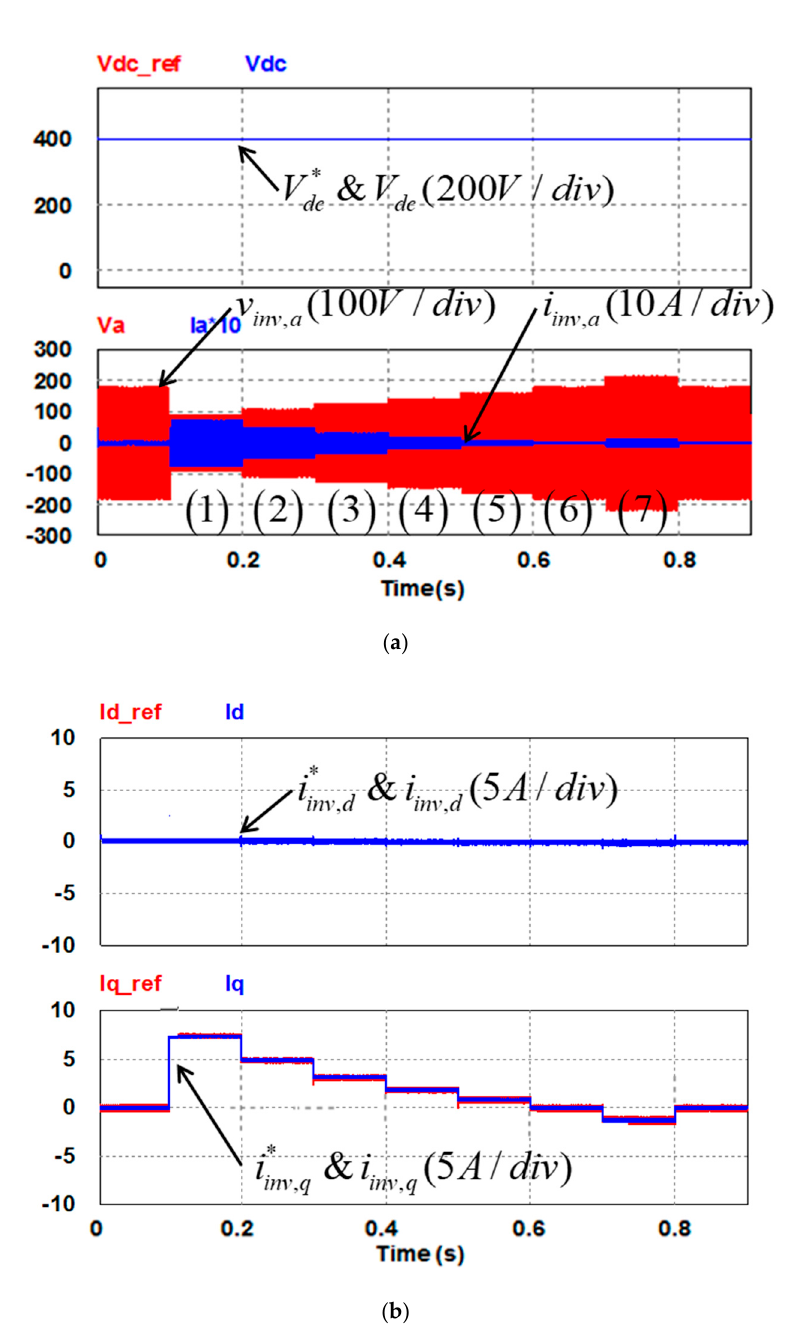
Figure 10. Simulation results of LVRT capability: ( a ) DC voltage and its command signal/grid phase A voltage and current (20 times); ( b ) inverter d-axis current and its command/q-axis current and its command.